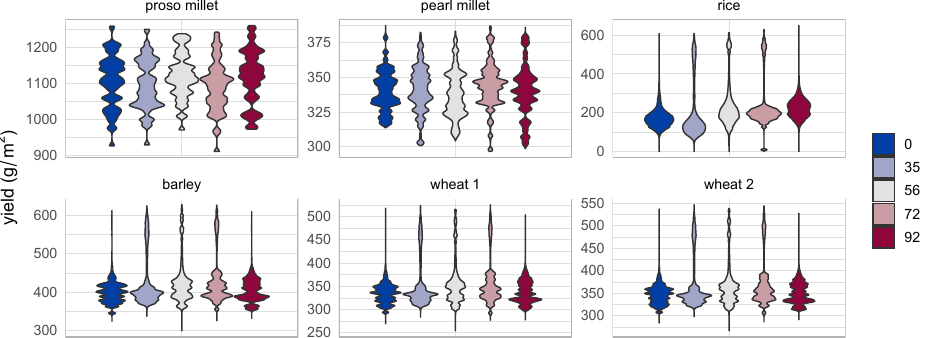
Figure 9. Yield of land units per crop and terrain in experiment 3. The comparison of yield patterns under different values of riverWaterPerFlowAccumu- lation (Figure 10) confirms the positive effect of inundation areas, with increasing river flow causing a higher frequency of high-productivity land units, particularly for those crops with higher S water . However, the experiment also raised a logical, yet easily